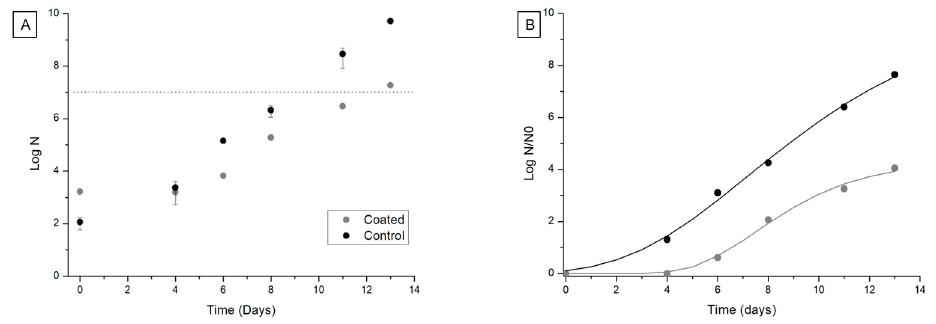
Figure 8. Total mesophilic aerobic count of salmon fillets treated with gelatin coating and stored at 2 ± 0.5 °C for 13 days ( n = 4). ( A ) Experimental data plot; ( B ) Gompertz model (lines) and normalized experimental data (points).